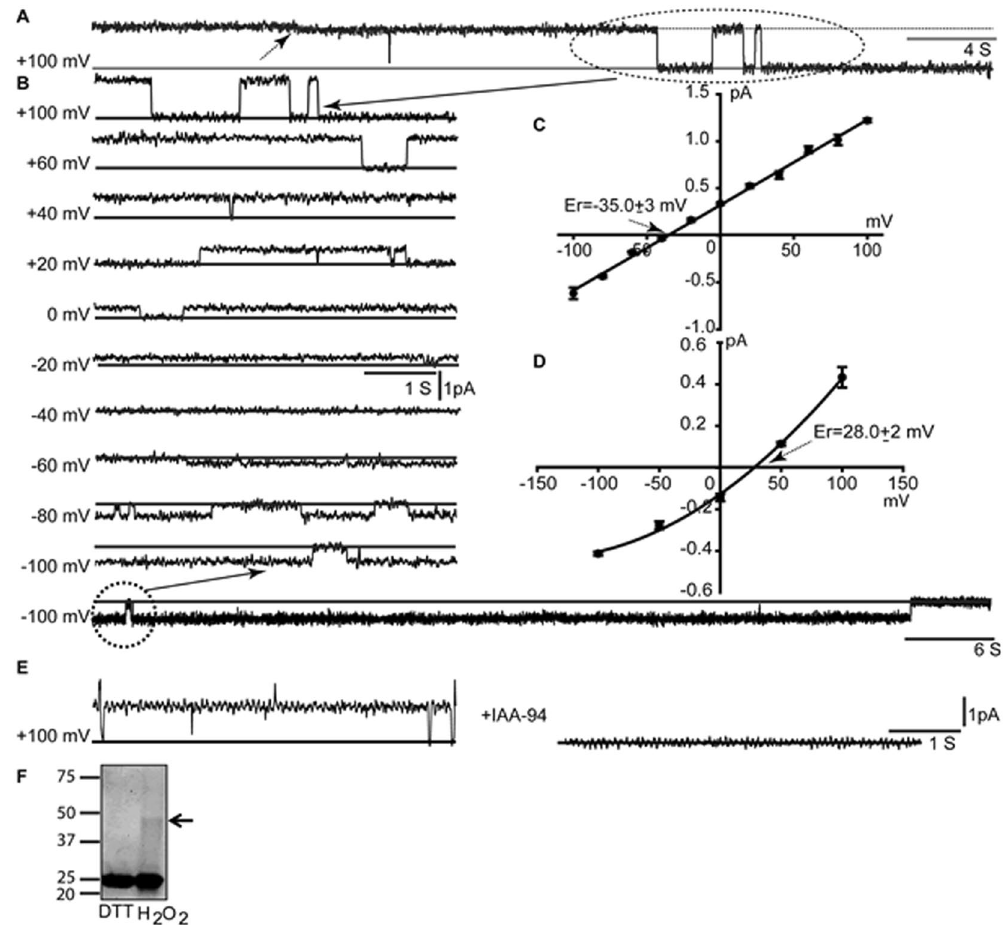
Figure 3. Single-channel properties of Ec SspA. Purified recombinant proteins were reconstituted in planar lipid bilayers at 500 mM:50 mM::cis:trans-KCl. ( A ) Representative trace of SspA at + 100 mV. A sub-state is indicated by a small arrow in the trace at the top. ( B ) Traces of single-channel currents of SspA at positive and negative holding potentials. The solid line indicates the closed level. ( C ) Current vs voltage (I/V) curve of SspA in asymmetric KCl. The single-channel conductance was 9.0 ± 1.5 pS (n = 8). The reversal potential was − 35.0 ± 3.0 mV. ( C ) Current vs voltage (I/V) curve of SspA in 500 mM:50 mM::cis:trans TrisCl. Error bars represent standard error of the mean. ( E) Representative traces showing that IAA-94 (100 µ M, n = 5) blocked the SspA channel activity. Reversal potential was 28.0 ± 2.0 mV, indicating an anion-selective channel. Error bars represent standard error of the mean. (F) SDS-PAGE (10%) polyacrylamide gel of SspA in the presence of H 2 O 2 (cropped from full-length gel shown in supplementary figure 3F). The arrow indicates the position of a